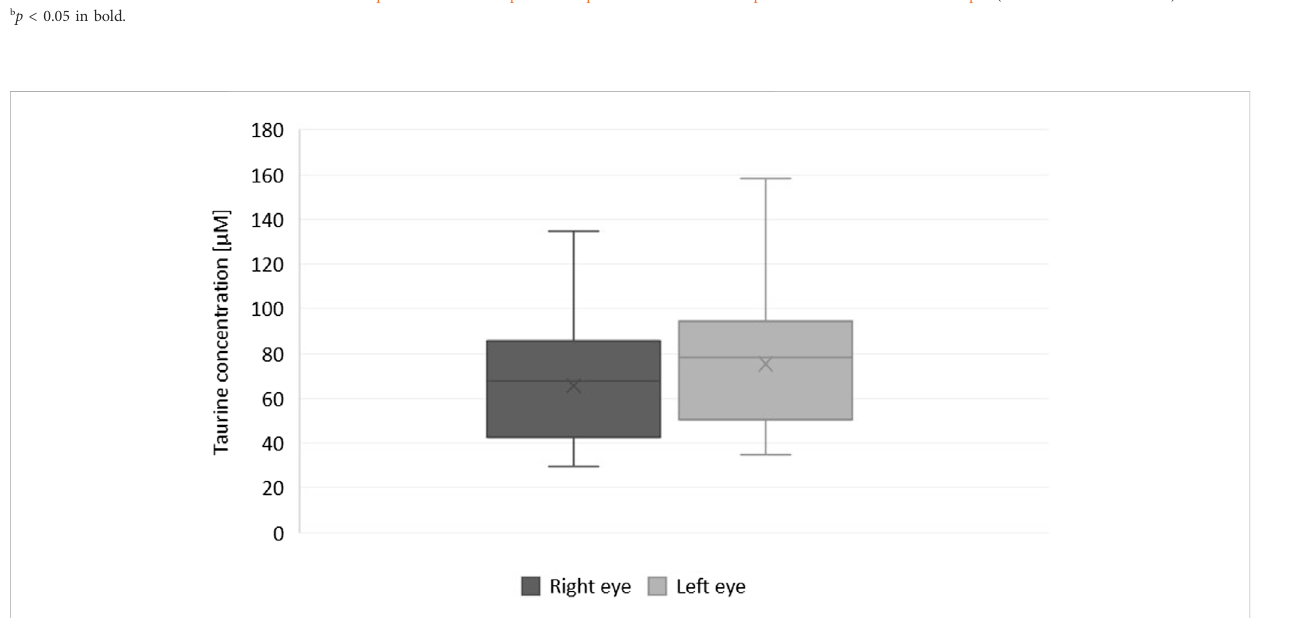
FIGURE 1 Box and whisker plot showing differences in the concentration of taurine in fellow eyes (Wilcoxon test with Benjamini – Hochberg correction for multiple comparisons, p =